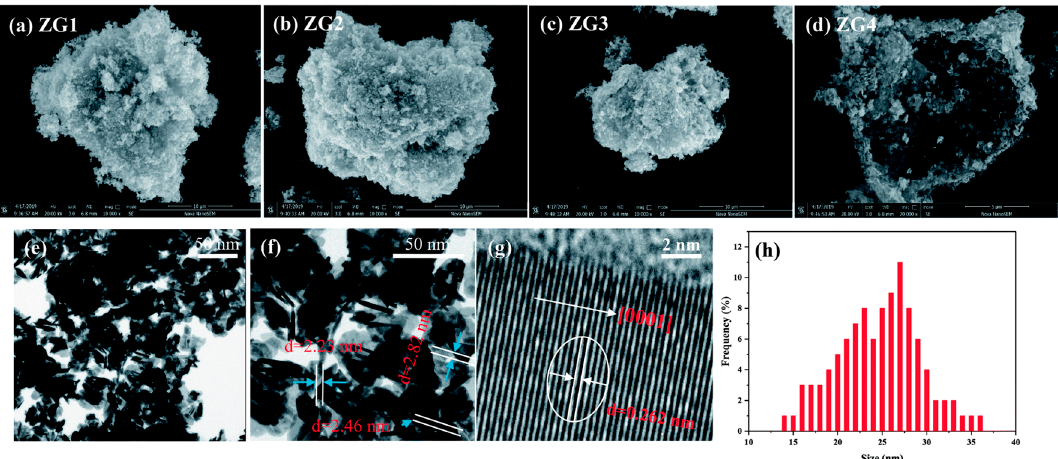
Figure 18. SEM images of ZnO ( a ) and ZrG-1 ( b ), TEM image of ZnO (inset of ( a )), TEM ( c ) and HRTEM ( d ) images of ZrG-1. Reproduced with permission from Elsevier [61].